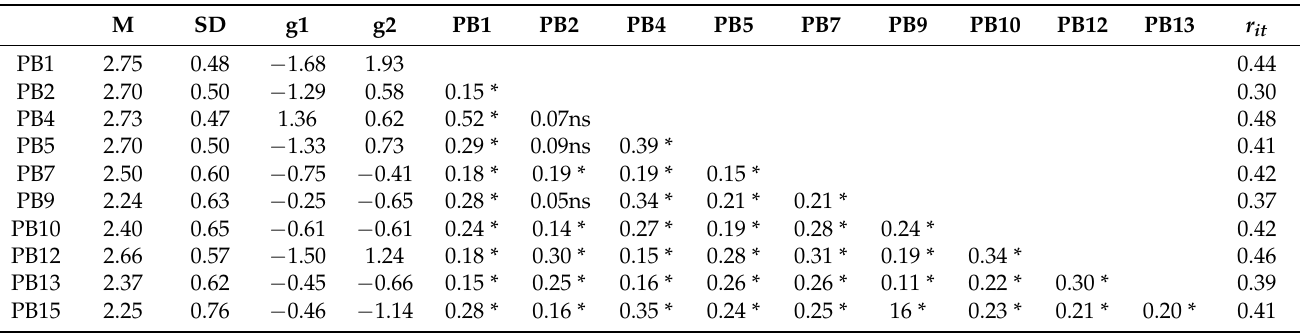
Table 3. Means (M), standard deviations (SD), skewness (g1), kurtosis (g2), inter-item correlations, and corrected item-total correlations (r it ).